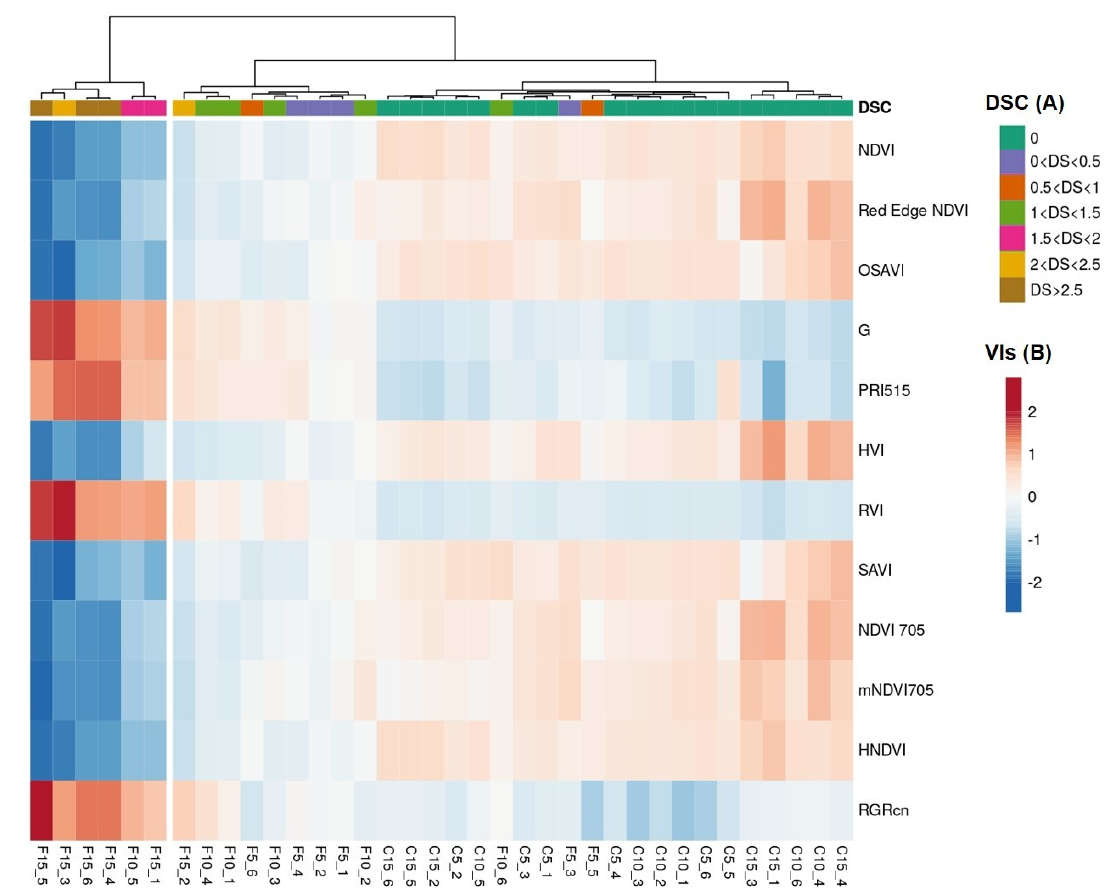
Figure 8. Heatmap obtained by hierarchical clustering of the 12 selected vegetation indices in relation to DSC. The analysis was conducted on infected (F, n = 18) and healthy (C, n = 18) wild rocket pots at 5, 10, and 15 dpi. DSC and VIs values represented following color scales A and B, respectively. Indices values (rows) were centered, and a unit variance scale was applied. The different observations (columns) were clustered using maximum distance and Ward linkage.